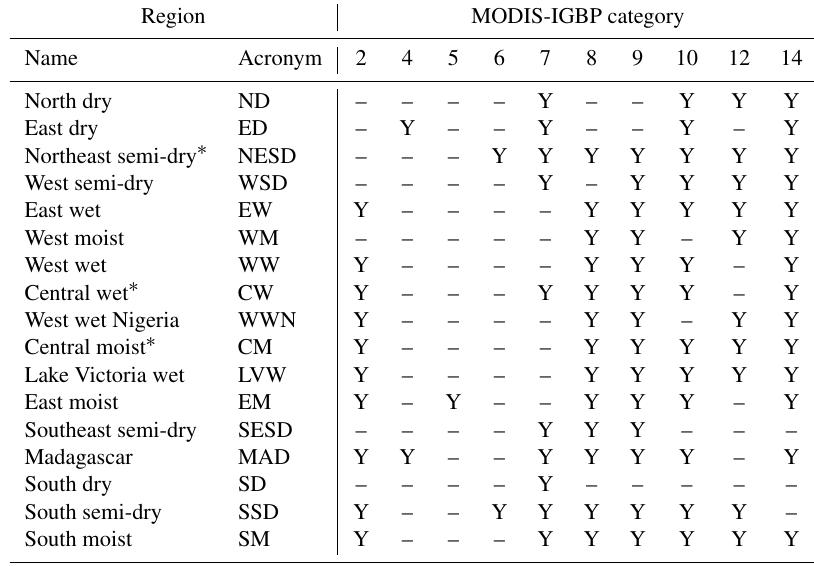
MODIS land use categories are numbered as follows: 2: evergreen broadleaf forest; 4: deciduous broadleaf forest; 5: mixed forest; 6: closed shrublands; 7: open shrublands; 8: woody savanna; 9: savanna; 10: grasslands; 12: croplands; 14: cropland and natural mosaic. Table 3. Dominant MODIS-IGBP land use categories within African bioclimate regions at 36km resolution.